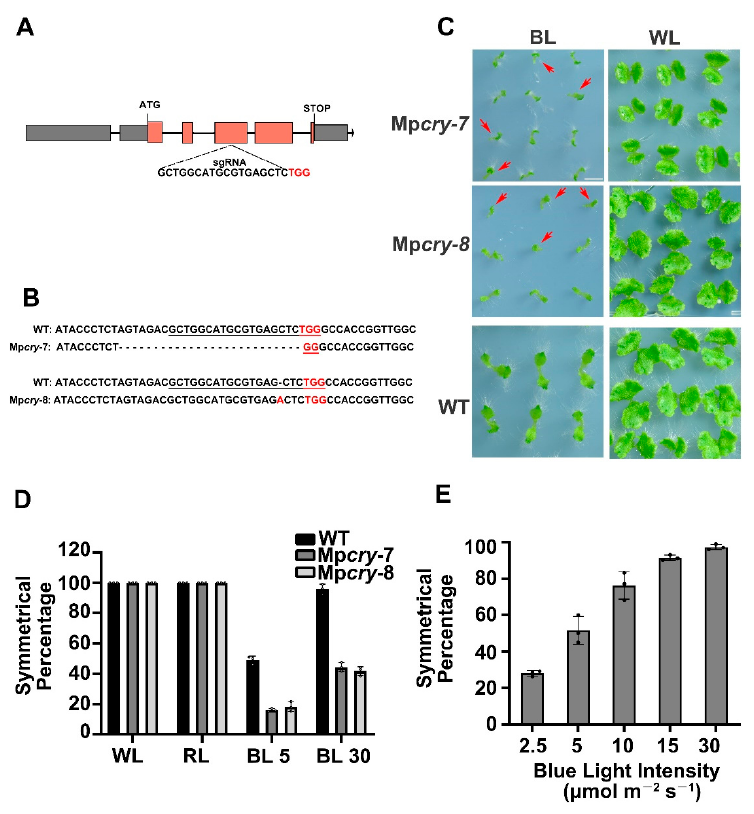
Figure 2. Growth of gemmalings of WT and Mp cry mutants under various BL conditions. ( A ) Schematic diagram of the structure of the MpCRY gene and the target sequence of CRISPR/Cas9 genome editing. Grey boxes indicate 5 (cid:48) UTR and 3 (cid:48) UTR. Orange boxes indicate CDS regions. Exons contain grey boxes and orange boxes. Black lines indicate introns. ( B ) Mp cry mutations detected by sequencing analysis. The PAM (protospacer adjacent motif) sequence is highlighted in red, and the target sequence is underlined in black. Dashes indicate deleted bases. ( C ) Photographs of gemmalings under BL or WL for 14 days. Bar = 5 mm. The red arrows represent individuals with asymmetric growth of thallus. ( D ) The symmetrical percentage represents the percentage of plants showing symmetric growth under the indicated light conditions. The gemmalings of WT, Mp cry-7 , and Mp cry-8 were grown under continuous WL (WL; 50 µ mol m − 2 s − 1 ), continuous RL (RL; 30 µ mol m − 2 s − 1 ) or continuous BL (BL; 30 µ mol m − 2 s − 1 ) for 14 days, respectively. Data are presented as mean ± SD ( n = 3 biological statistics). More than 100 gemmalings were used for one count. ( E ) The symmetrical percentage of WT thalli under continuous BL irradiation at various light intensities (2.5 to 30 µ mol m − 2 s − 1 ). Data are presented as mean ± SD ( n = 3 biological statistics). More than 100 gemmalings were used for one